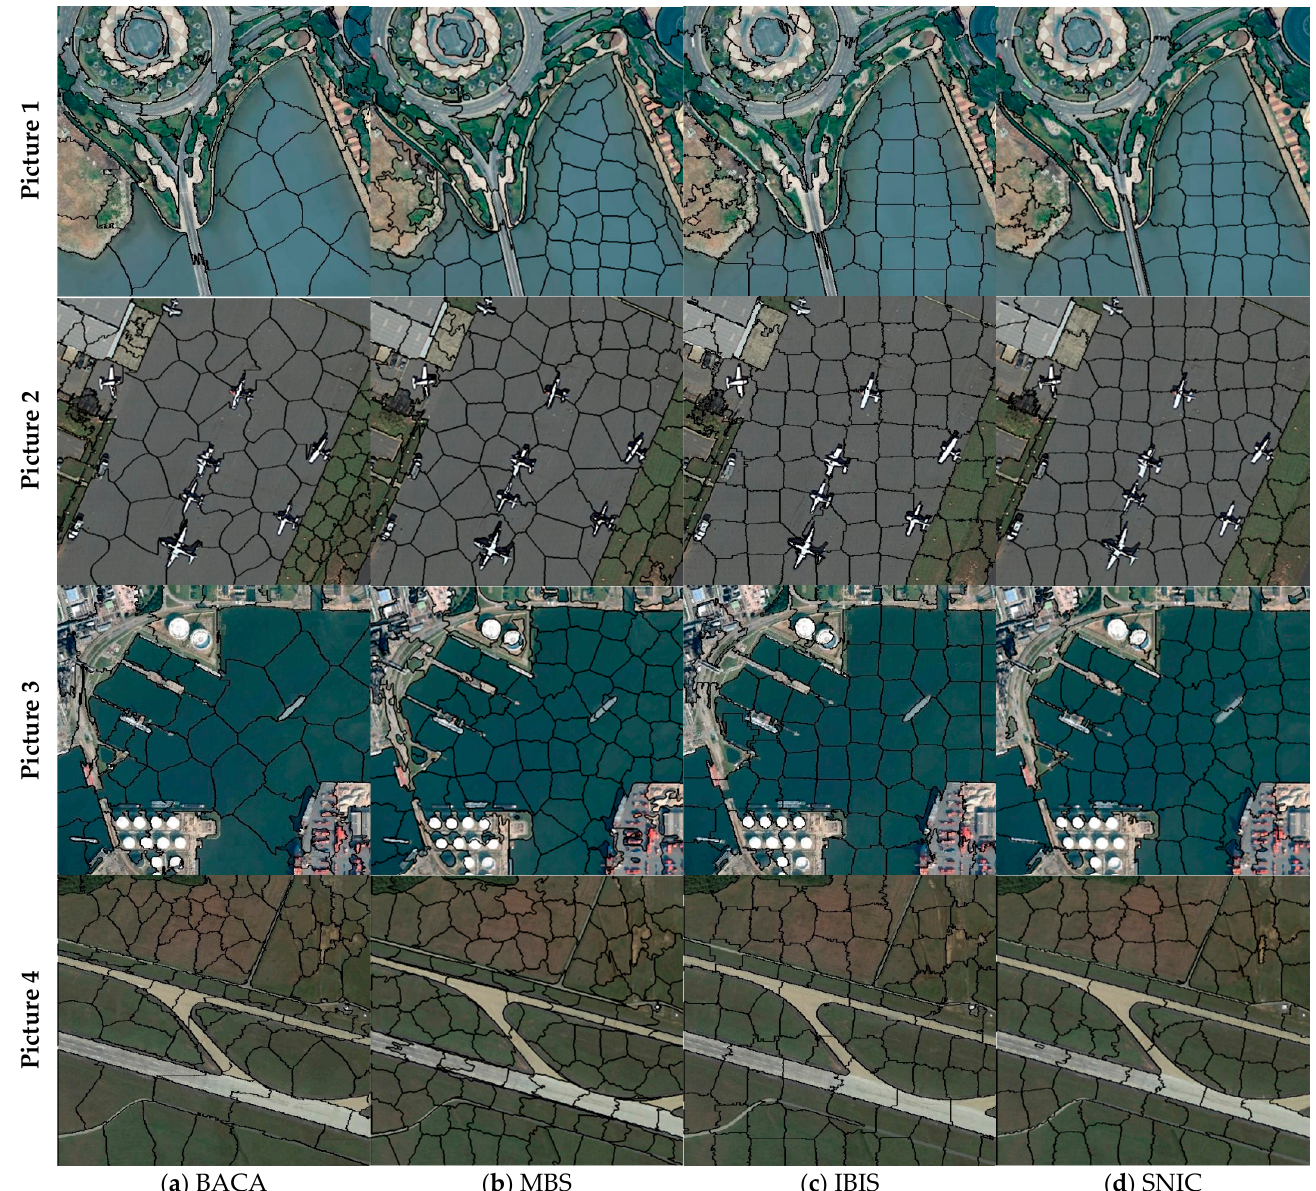
Figure 13. Visual comparison of segmentation results with 100 expected superpixels. ( a ) BACA; ( b ) MBS; ( c ) IBIS; ( d )